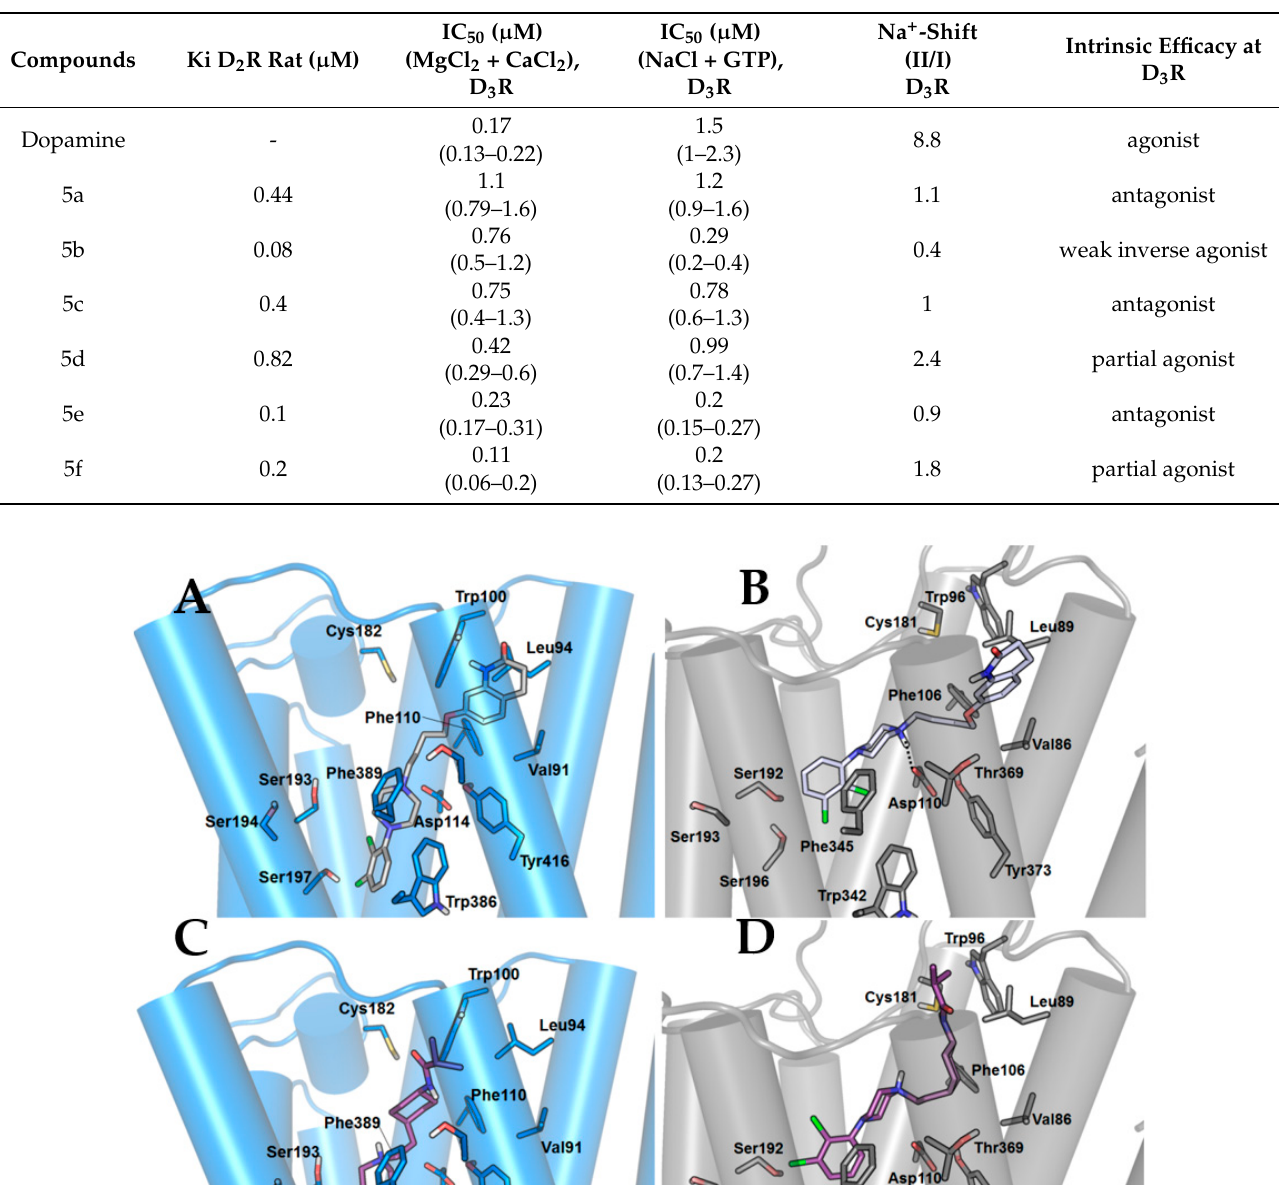
Table 1. Affinities and intrinsic efficacies of the new derivatives. The IC 50 values were calculated from the mean curves of two to six experiments [n] performed in triplicate and are expressed with their 95% confidence intervals (in parentheses). For D 2 R, the K i value was calculated from the Cheng– Prusoff equation. For D 3 R, the Na+-shifts were calculated by dividing the IC 50 value obtained in the medium containing NaCl and GTP(II) by the IC 50 value obtained in the medium containing MgCl 2 and CaCl 2 (I). Na+-shifts lower than one indicate that the compounds are weak inverse agonists. Na+-shifts similar to one indicate that the compounds act as antagonists, whereas agonists have higher values.